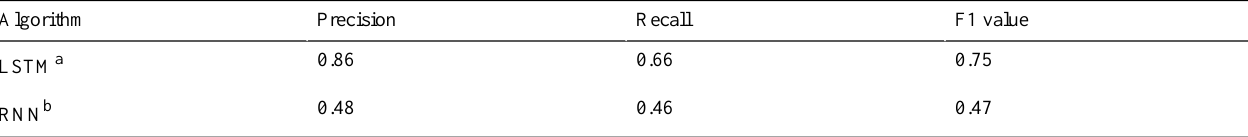
Table 5. Experimental results of neural network